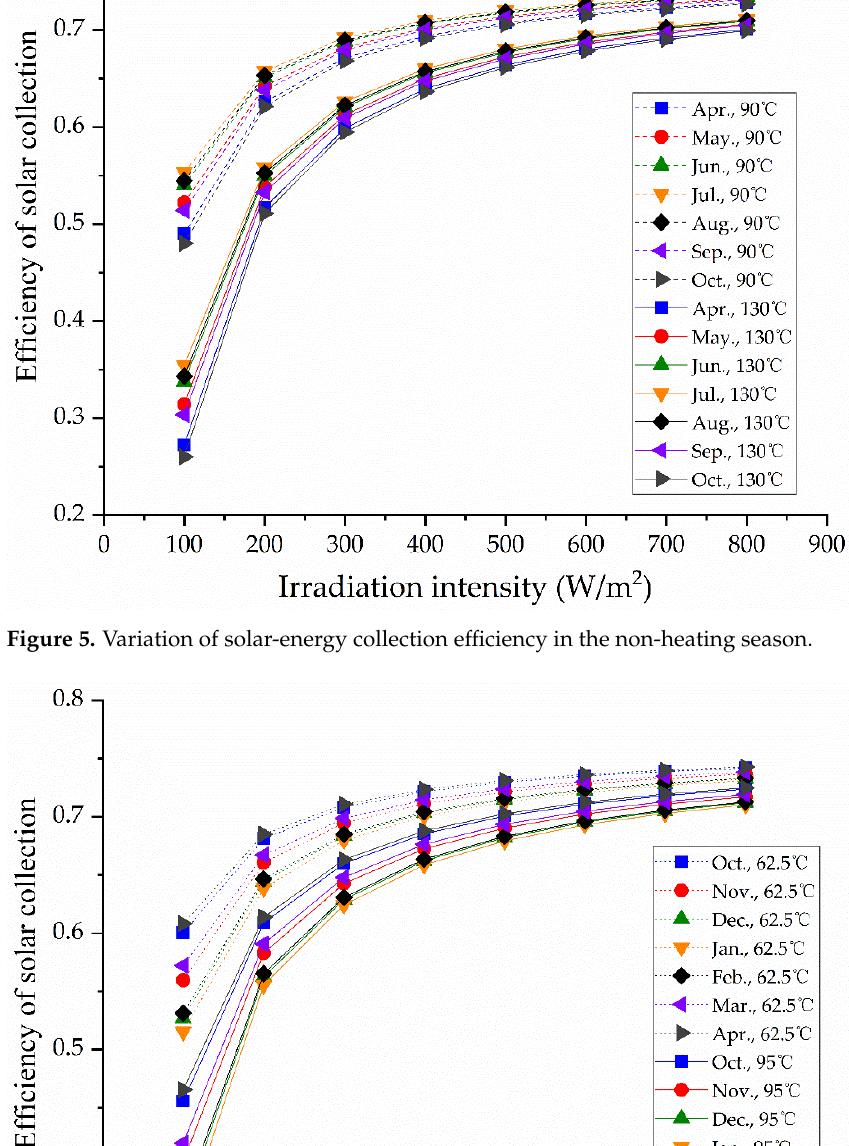
Figure 4. Daily irradiation intensity hour by hour in the non-heating season.